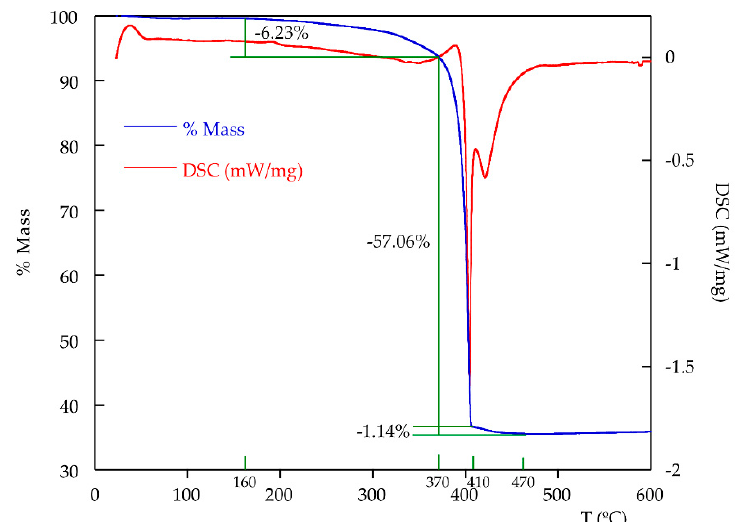
Figure 5. Themogravimetric curves obtained for compound 2 .